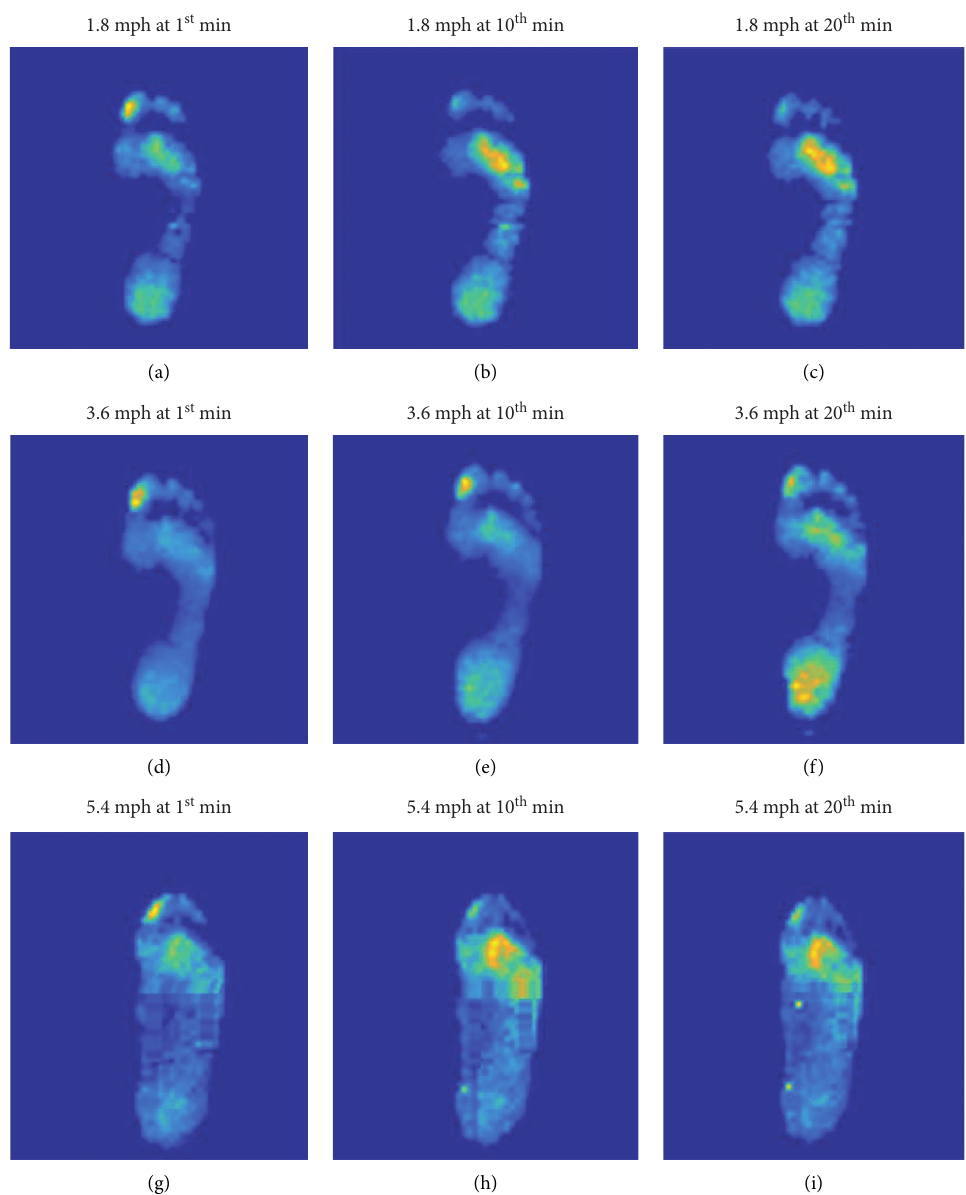
Figure 1: Examples of plantar pressure images after different walking speeds. Plantar pressure patterns at the 1 st min (a), 10 th min (b), and 20 th min (c) during walking at 1.8mph. Plantar pressure images at the 1 st min (d), 10 th min (e), and 20 th min (f) during walking at 3.6 mph. Plantar pressure patterns at the 1 st min (g), 10 th min (h), and 20 th min (i) during walking at